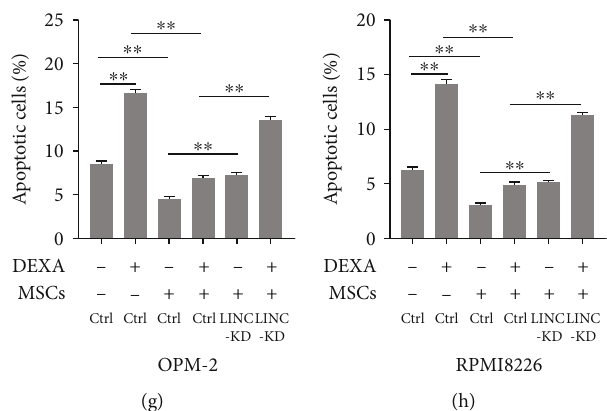
Figure 6: Knocking down of LINC00461 inhibited cell proliferation and promoted apoptosis. (a, b) The OPM-2 or RPMI8226 cells were cocultured with MSCs in a transwell 6-well microplate with or without dexamethasone (10 μ M) and transfected the cells with LINC00461 siRNA. After 48 hours, cell viability was determined using the MTT assay. Besides, (c – f) cell number and colony formation assays were also determined on the OPM-2 and RPMI8226 cells. (g, h) The OPM-2 or RPMI8226 cells were cocultured with MSCs in a 6-well microplate with or without dexamethasone (10 μ M) and transfected the cells with LINC00461 siRNA. After 48 hours, cell apoptosis assay was determined by using fl ow cytometry. Ctrl: scramble siRNA. One-way ANOVA for the data in (a), (b), (e), (f), (g), and (h). Two-way ANOVA for the data in (c) and (d). ∗∗ p < 0 : 01